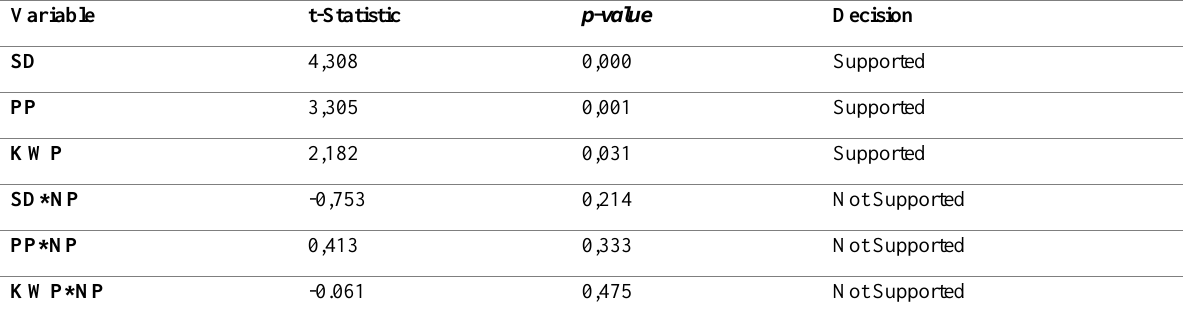
Table 2: Summary of hypothesis testing